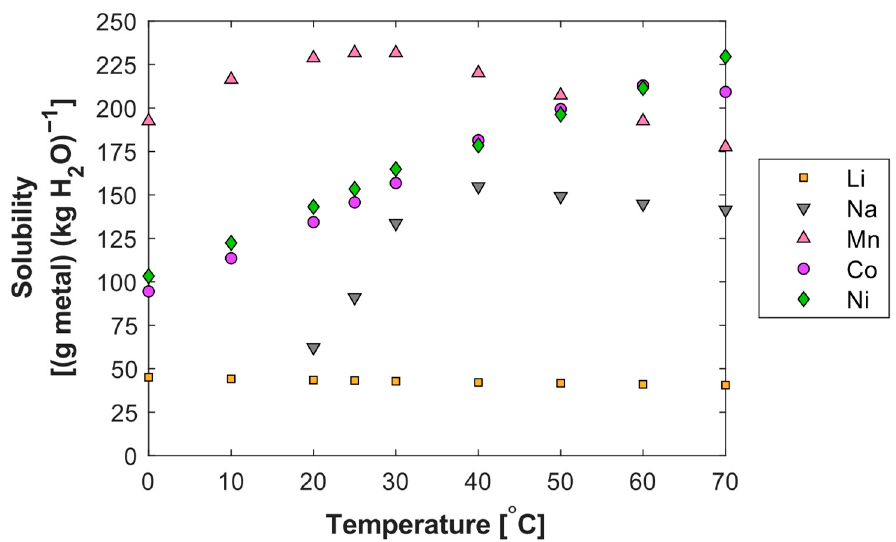
Figure 12. Solubilities of the metal sulfates in water (binary systems) at different temperatures given as grams of metal cations per kilogram of water. Data from [34,35].